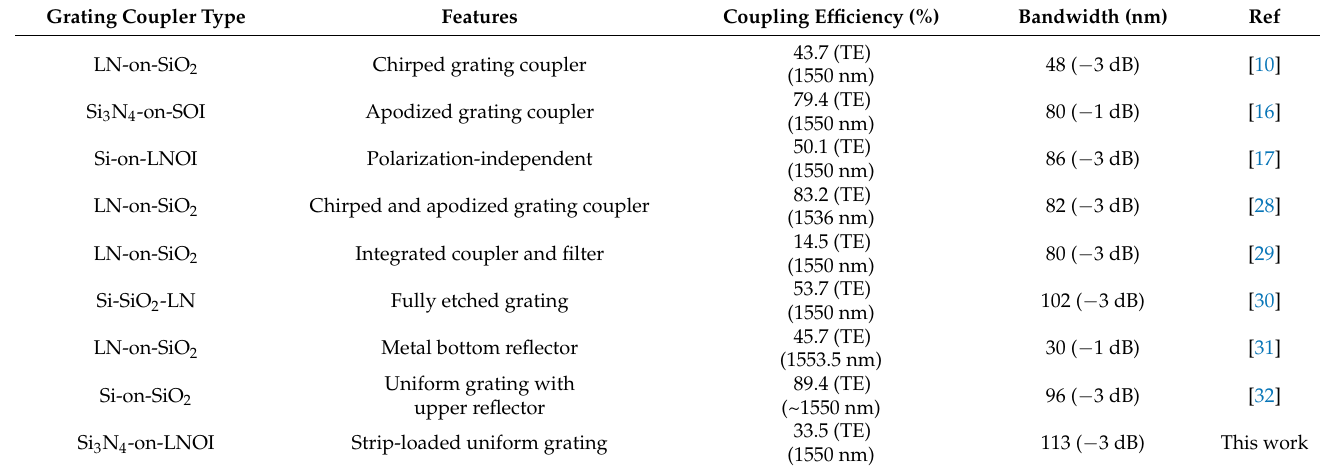
Table 2. A comparison of the reported grating couplers in this work.